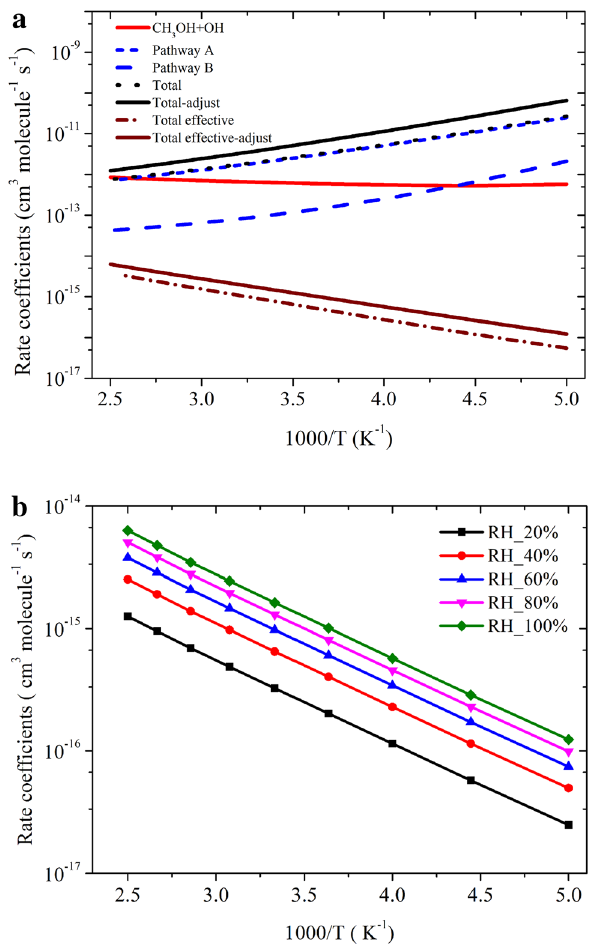
Figure 11. Rate coefficients for CH 3 OH + OH (+ H 2 O) ( a ) 100% relative humidity (RH), ( b ) at different RH of